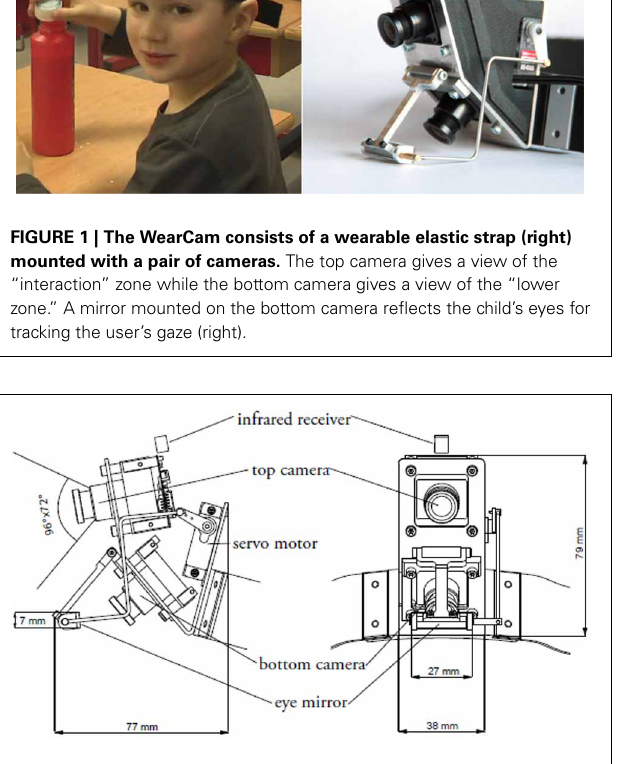
FIGURE 2 | Schematics of the WearCam: the two CCD cameras, servo motor and mirror for reflecting the child’s